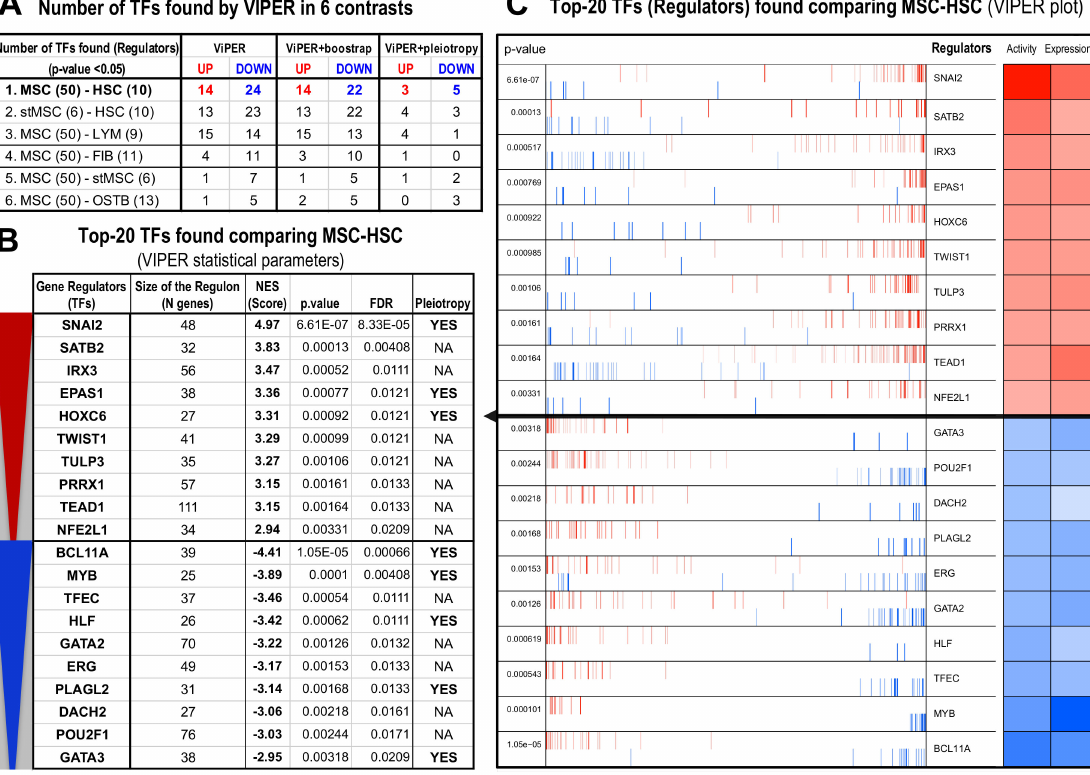
Figure 2. Gene regulators (TFs) and associated gene regulons found using VIPER (Algorithm for Virtual Inference of Protein-activity by Enriched Regulon analysis) in the comparison of the expression profiles of MSCs versus the other 5 related cell types, most of them present in the human bone marrow: ( A ) Table showing the number of TFs up- or downregulated and found in each comparison; ( B ) table with the top 10 up- and downregulated TFs found, including the parameters provided by VIPER (normalized enrichment score (NES), p -value, false discovery rate (FDR), and pleiotropy); and ( C ) plot produced by VIPER presenting the top 20 upregulated (red) and downregulated (blue) TFs that illustrates the strength of the protein activity and the RNA expression (darker colors higher